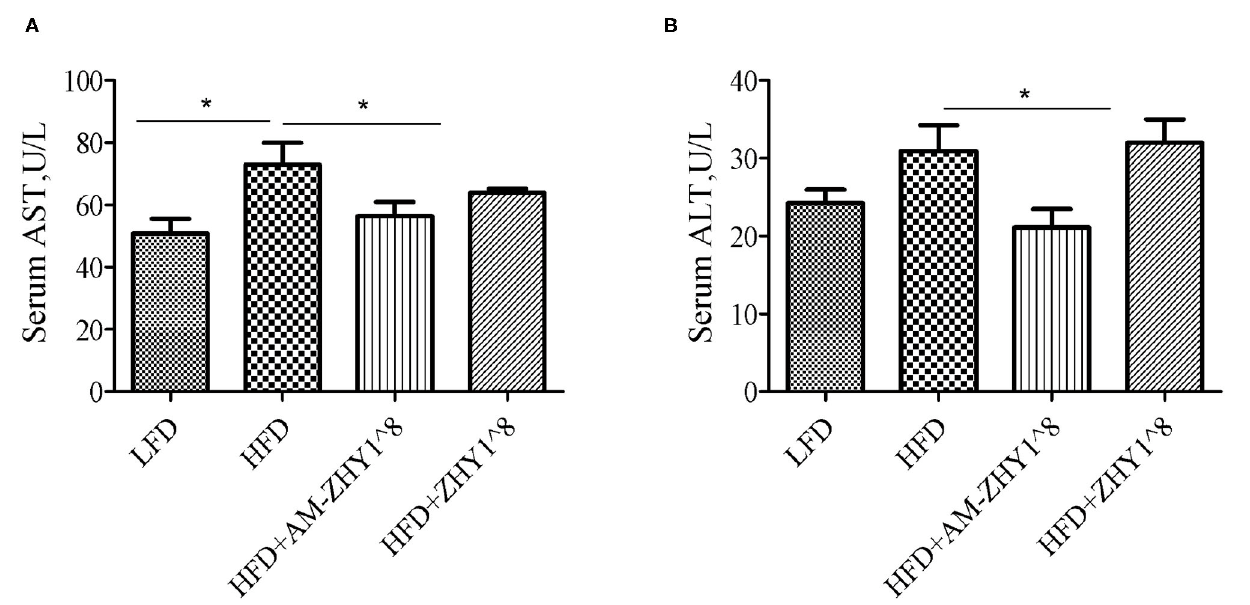
FIGURE 6 | Serum alanine aspartate aminotransferase [AST, (A) ] and alanine aminotransferase [ALT, (B) ] levels of zebrafish fed with a basal diet and high-fat diet, with AM-ZHY1(10 8 cfu/g) and ZHY1(10 8 cfu/g) supplemented with the high-fat diet. Data are presented as mean ± SEM ( n = 6). The asterisks on the horizontal line represent significant differences between the two groups. * p <